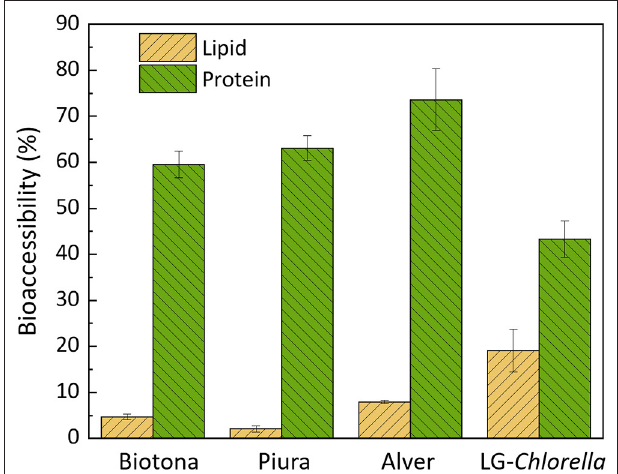
FIGURE 2 | Fatty acids and protein bioaccessibility (%) in microalgae biomasses, expressed as mean of digestion triplicates ( n = 3) ± standard